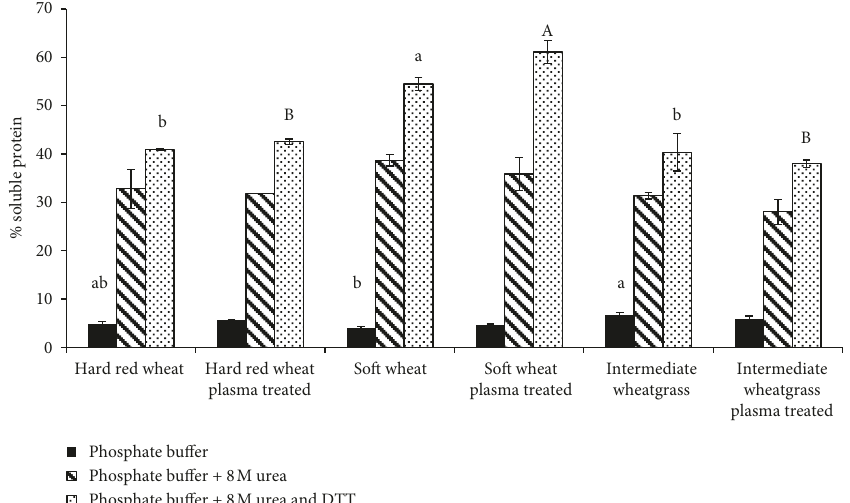
Figure 1: Protein solubility of hard red wheat, soft wheat, and intermediate wheatgrass flour in three solvents (pH 7 phosphate buffer containing 0.1M sodium chloride, the same buffer with additional 8M urea, and buffer with 8M urea as well as 0.01M dithiothreitol (DTT)). Error bars represent standard deviations, different lowercase letters represent differences in the solubility in the same solvent among samples before plasma treatment, and uppercase letters represent differences after plasma treatment, assessed via Tukey’s HSD test ( p < 0 . 05). Solubility in pH 7 phosphate buffer did not significantly differ in plasma-treated samples, and solubility in pH 7 phosphate buffer with 8M urea did not significantly differ among any